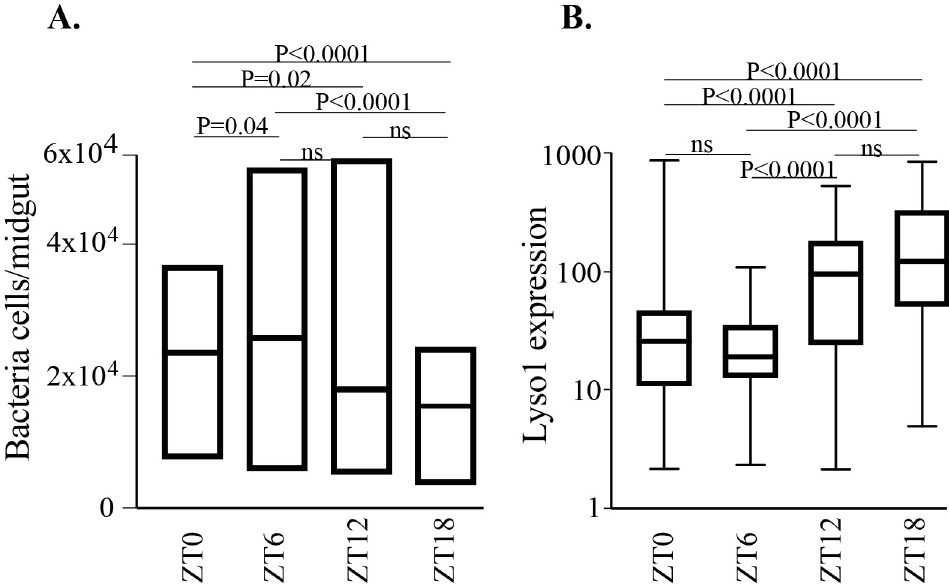
Fig 2. Diurnal dynamics of mosquito midgut microbiota and the expression of antibacterial gene lysozyme c-1 ( LYSC-1 ). Floating bars (A) represent maximum to minimum microbiota count at different timepoints, where the horizontal bar represents the median count, and box plot (B) represent the level of relative expression (ng/mosquito) of LYSC-1 determined using RT-qPCR on tRNA extracted from mosquitoes sampled at different ZT.